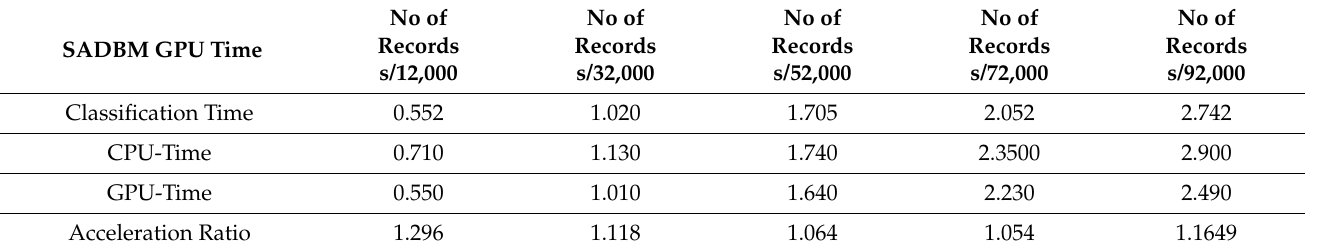
Table 3. Acceleration ratio to classify the records using